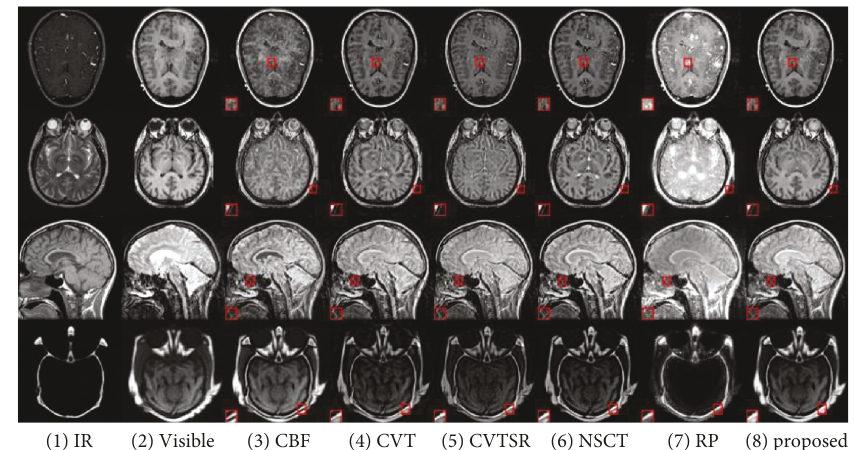
Figure 7: Comparison of the fusion results from different methods on the source